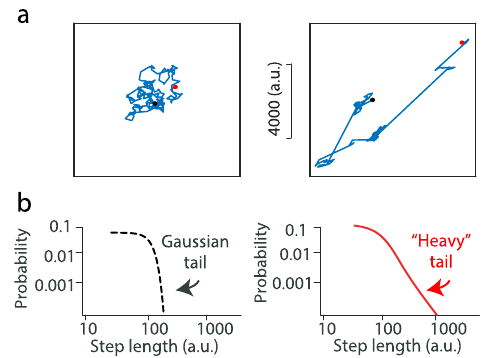
Fig. 1 Comparison of Gaussian (Brownian) and Lévy walk dynamics. a Trajectory of Brownian motion (left) and that of Lévy walk (right). The initial and fi nal positions are respectively indicated by fi lled red and open black circles. b Schematic log-log plots of the probability distributions of step lengths for Brownian motion (Left) and Lévy walk (right).